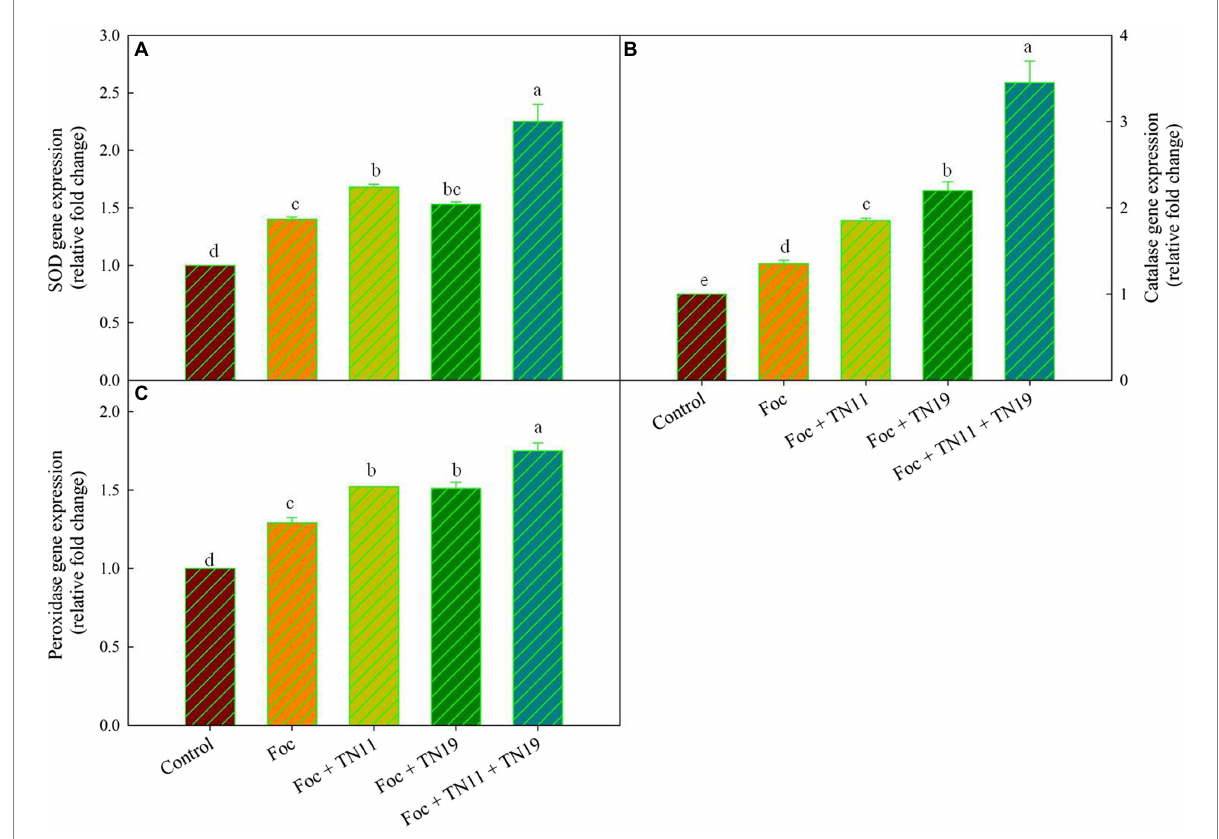
FIGURE 3 Relative expression of (A) superoxide dismutase (SOD), (B) catalase (CAT), (C) peroxidase (POD), gene in chickpea leaves under unprimed control, Foc challenged, Foc challenged + TN11 primed, Foc challenged + TN19 primed, and Foc challenged + TN11 + TN19 primed, conditions. The data are the mean of three replicates ± standard error, within each graph, values followed by the same letter are not significantly different ( p ≤ 0.05) according to Duncan’s multiple range